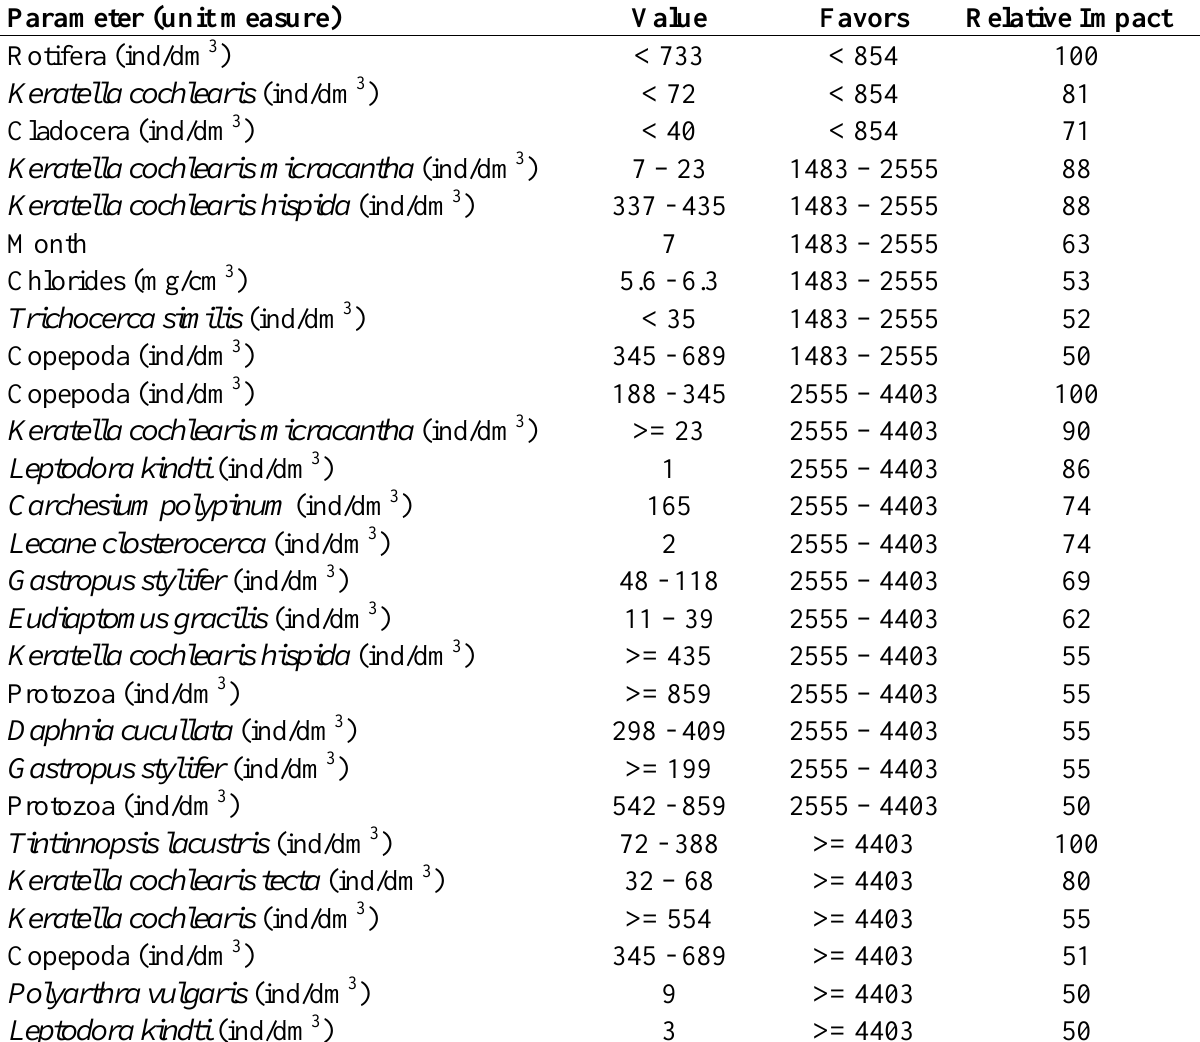
Table 1. Key Influencers Report and their impact over the values of total zooplankton (ind/dm 3 ) with zooplankton groups and species for the Grošnica